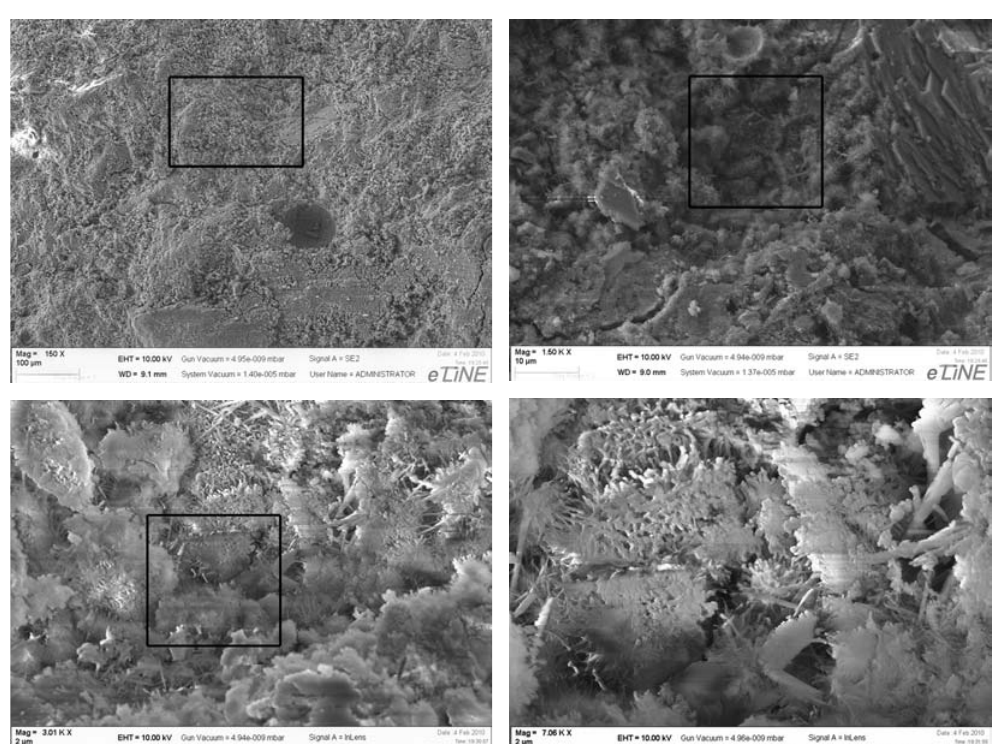
Fig. 10 . The structure of D2 series concrete